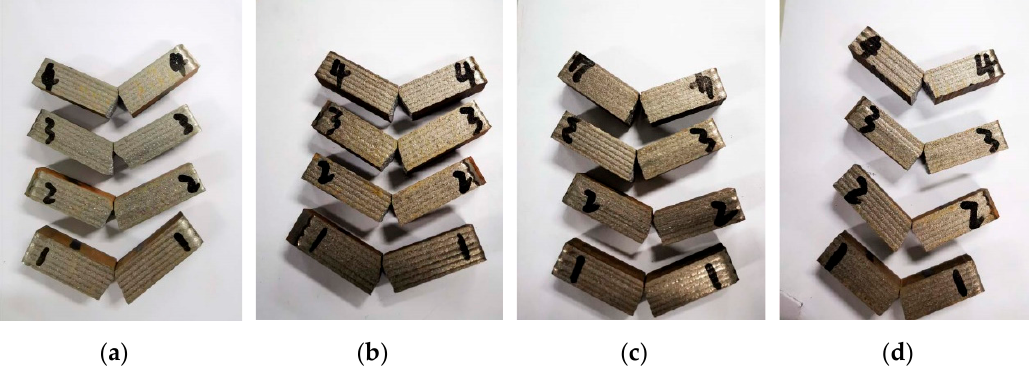
Figure 10. Charpy impact test of the laser cladding sample: ( a ) 1200 W; ( b ) 1400 W; ( c ) 1600 W; ( d ) 1800 W.